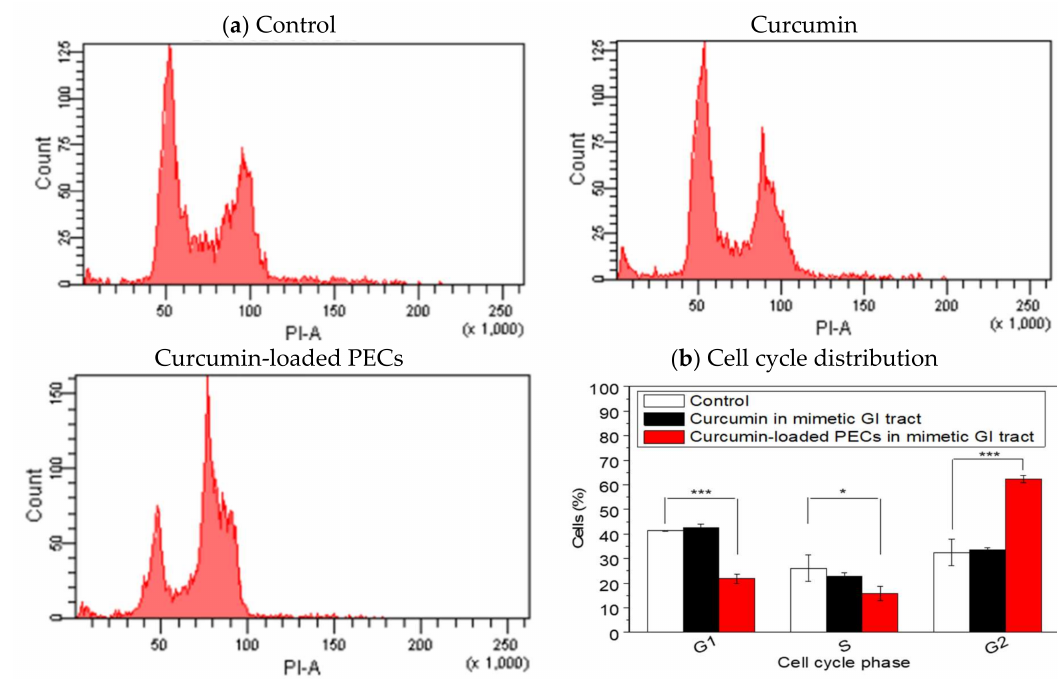
Figure 8. Cell cycle profiles of HCT116 cells treated with curcumin and curcumin-loaded PECs after incubation in mimetic GI tract conditions. ( a ) Curcumin and curcumin-loaded PECs (curcumin concentration was 6.8 µ M) were pretreated with mimetic GI tract conditions, and HCT116 human colon cancer cells were then treated and the curcumin or curcumin-loaded PECs for 12 h. The cells were then fixed and stained with PI and cell cycle was analyzed using flow cytometry; ( b ) Cell cycle distribution was also analyzed using ModFit LT 3.0. The results have been statistically compared and analyzed using Student’s t -test (Microsoft Excel 2000). Differences were recognized as statistically significant when the p values were less than 0.05, and significant differences are shown in star marks (* p < 0.05 and *** p <